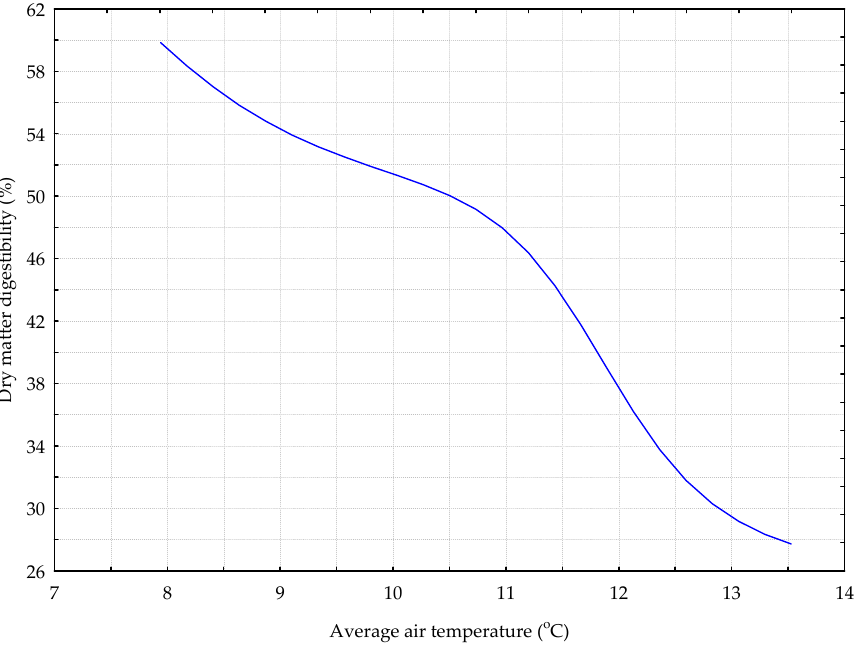
The relation between the yield of dry matter from the sward with the predominance of grasses and red clover (Y_GB model) and the average daily air temperature (T_AV) is shown on Figure 10. The average daily air temperature in the period ranging from the spring onset of vegetation to the harvest date stimulated the yield of dry matter from the sward with the predominance of grasses and red clover.